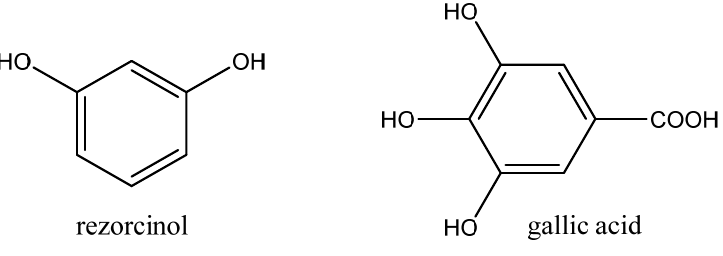
Figure 11. Structures of resorcinol and gallic acid.